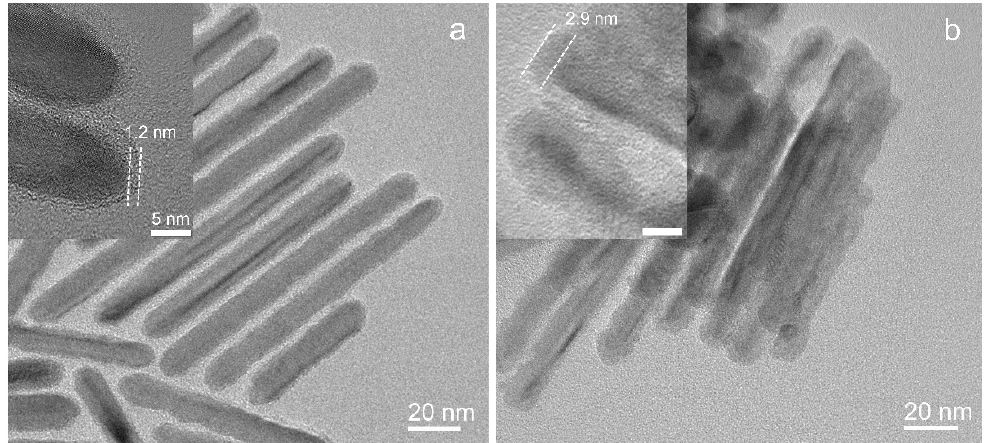
Figure 4. TEM images of Cu NRs with the addition of ( a ) 10 µ L and ( b ) 60 µ L of NaHS solution. The insets show the amplifying TEM images around the tip region of sulfurized Cu NRs.